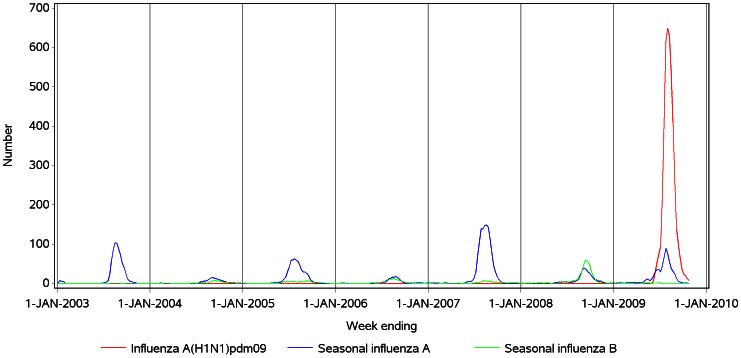
Influenza laboratory detection time series, persons of all ages, Australia, 2003 to 2009.Notes: 1. The values shown are the moving average of the current and previous two weeks, as used in the regression models (see Table S1 in File S1).